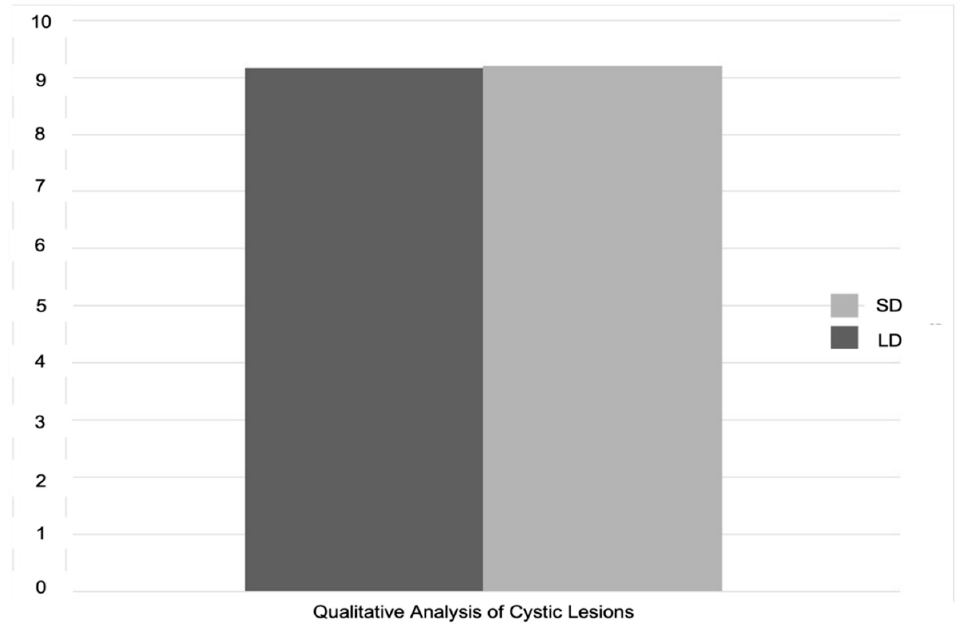
Figure 3. The qualitative analysis of the visibility of cystic lesions according to the dose mode using a scale from 1 (very low) to 10 (very high). Regarding the visibility of cystic lesions, an average value of 9.16 in low dose protocol and 9.19 in standard-dose protocol was